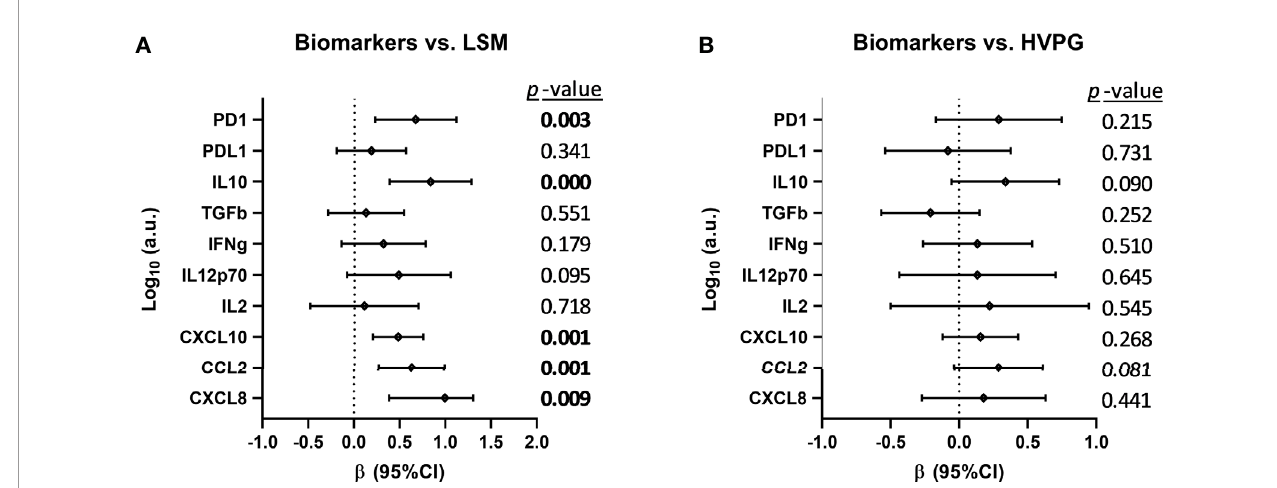
FIGURE 2 | Association between changes in plasma biomarkers and liver disease severity scores (A) [liver stiffness measurement (LSM) and (B) hepatic venous pressure gradient (HVPG)] after successful all-oral direct-acting antiviral treatment in HIV/HCV-coinfected patients with advanced cirrhosis. Data were calculated by GLMM models. Values are expressed as regression coef fi cient ( b ) and 95% of con fi dence interval (95%CI). The statistically signi fi cant differences are shown in